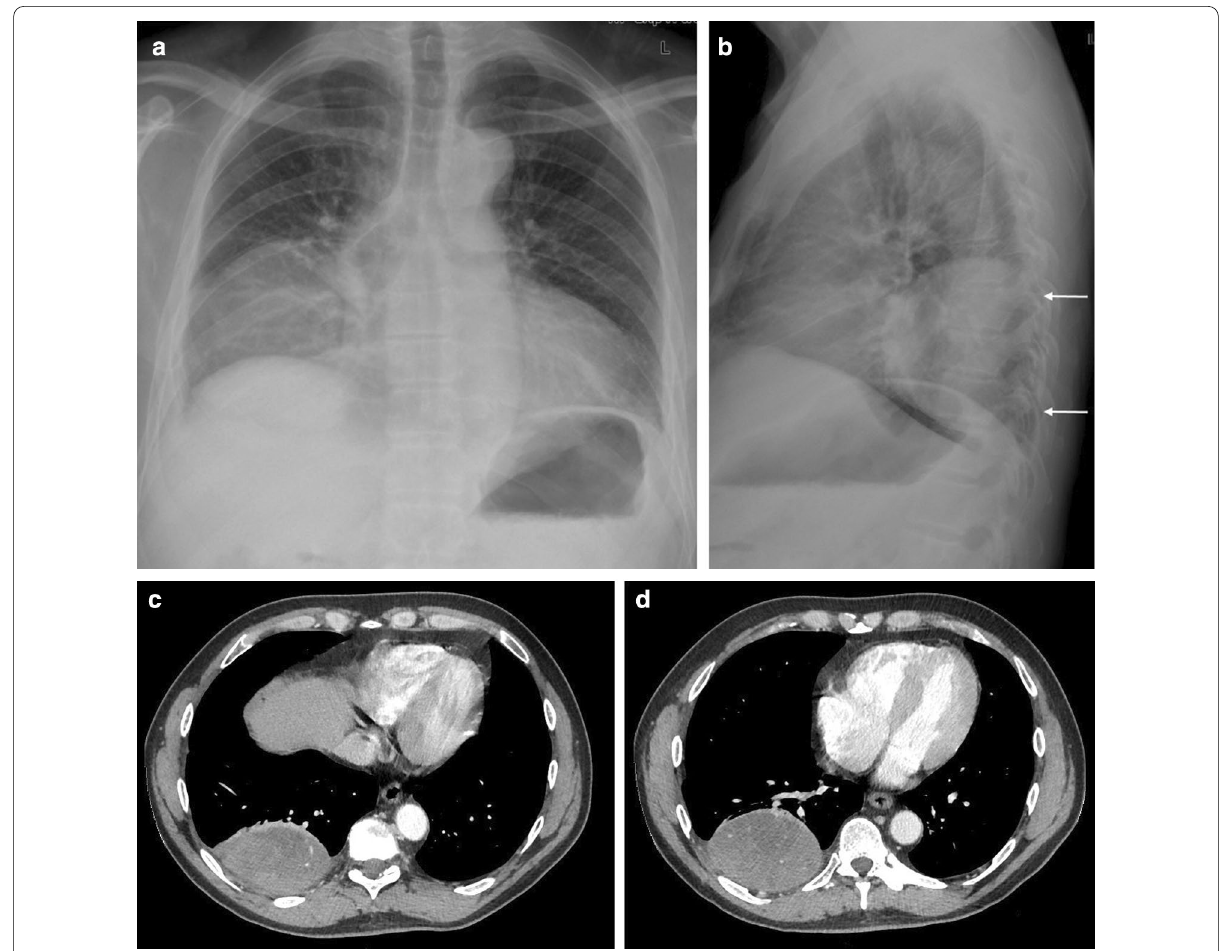
Fig. 2 Diagnosis: solitary fibrous tumor. Technique: standard chest radiography and contrast-enhanced chest CT. Description: A 65-year-old man presented with acute right-sided posterior chest pain. There was no history of weight loss. Postero-anterior and lateral chest radiographs ( a , b ) show a well-circumscribed mass located posteriorly in the right lower lobe with an incomplete border sign (white arrows), suggestive of an extrapulmonary mass. Axial contrast-enhanced CT ( c , d ) shows a well-defined, heterogeneous mass with intralesional hypodense areas of necrosis and hyperdense calcifications. Imaging findings were suggestive of a solitary fibrous tumor. Histopathologic examination of the resected mass confirmed this diagnosis, showing signs of